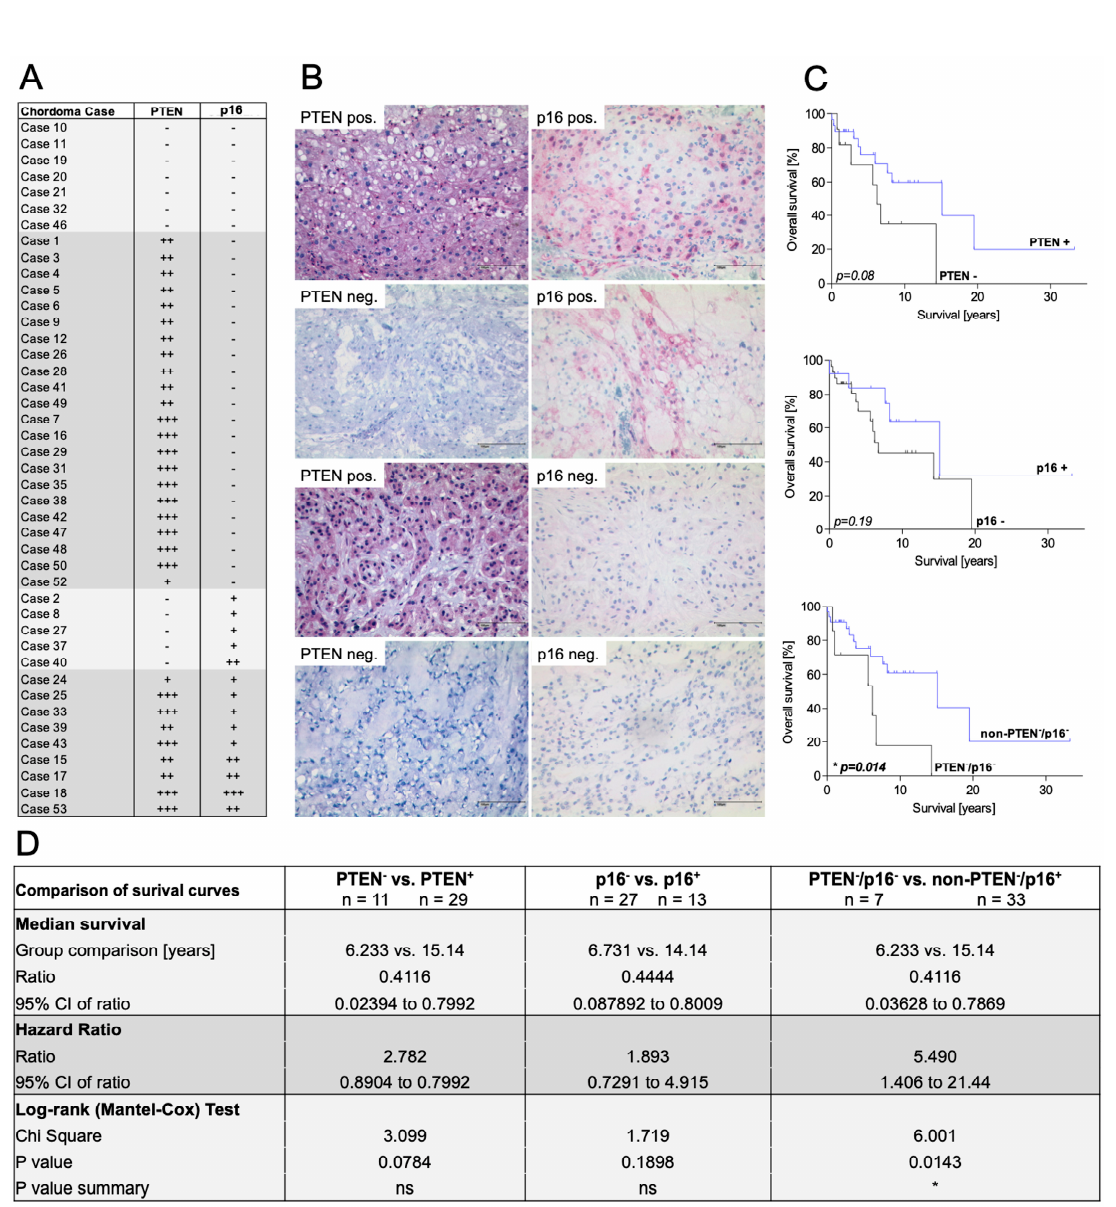
Figure 2. Immunohistochemical analysis of the chordoma tissue cohort. ( A ) Overview of included chordoma patients and their respective PTEN and p16 statuses. Arbitrary scoring -, +, ++, +++ was used to assess the degree of immunostaining. ( B ) Different constellations of immunohistological PTEN and p16 staining in selected chordoma tissues (scale bar = 100 µm). ( C ) Overall survival in terms of dependence on the PTEN and p16 statuses. A significantly shorter overall survival was observed in PTEN − /p16 − cases. ( D ) Median survival, hazard ratio, and logrank (Mantel–Cox) test of the subgroups.